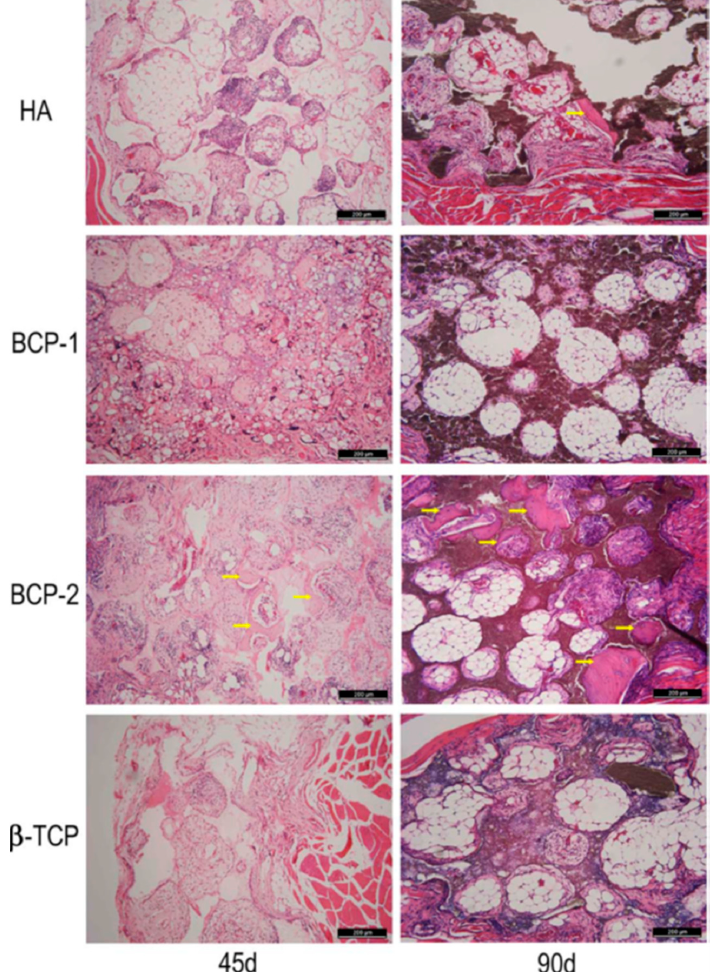
Figure 5. Photomicrographs of hematoxylin and eosin staining for the decalcified sections of porous Calcium Phosphate-based ceramics implanted into the thigh muscles of mice for 45 and 90 days. Yellow markers indicate the newly formed bone. Bar, 200 µm, reproduced with permission from [149]. Resorbable ceramics such as β - and α -TCP have the advantage of degrading gradually over a period of time while the natural host tissue regenerates itself and replaces the degrading scaffold [151]. On the other hand, hydroxyapatite (HAp) possess a porosity similar to that of native bone tissue thus promoting bone growth within the pores of the scaffold [152]. Macroporous HAp scaffolds with interconnected oval shaped pores have been found to exhibit enhanced cellular functionality and supports osteoclast differentiation in comparison to the results found for dense HAp scaffolds [153]. Additionally, it has been reported that during the degradation process of HAp, calcium and phosphate ions are released which help to induce osteogenic response and contribute to the osteoinductivity of the HAp scaffold [154]. However, its use as a scaffold material is limited because